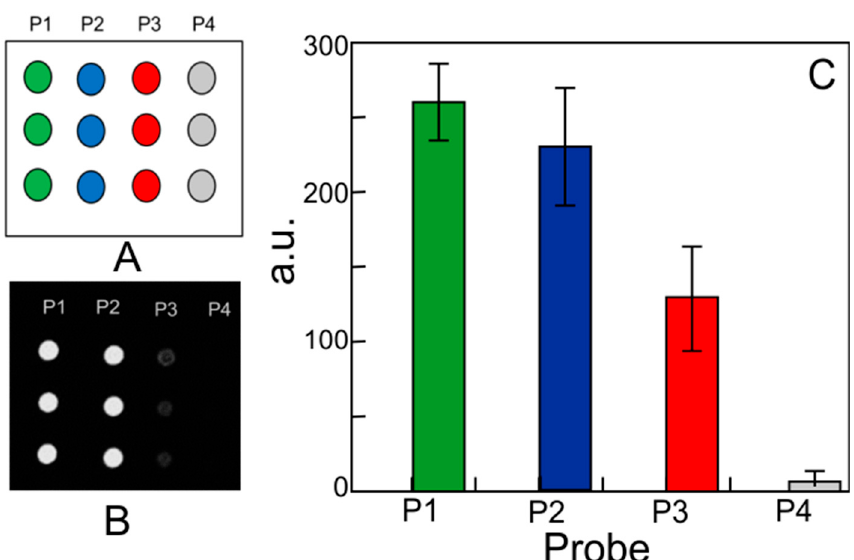
Figure 10. Microarray hybridization experiment: ( A ) microarray layout; ( B ) SiO 2 fluorescence images after hybridization with Cy5 ‐ labed DNA PM targets; ( C ) fluorescence intensity analysis for P1, P2, P3, and P4 probes for the SiO2 surface.